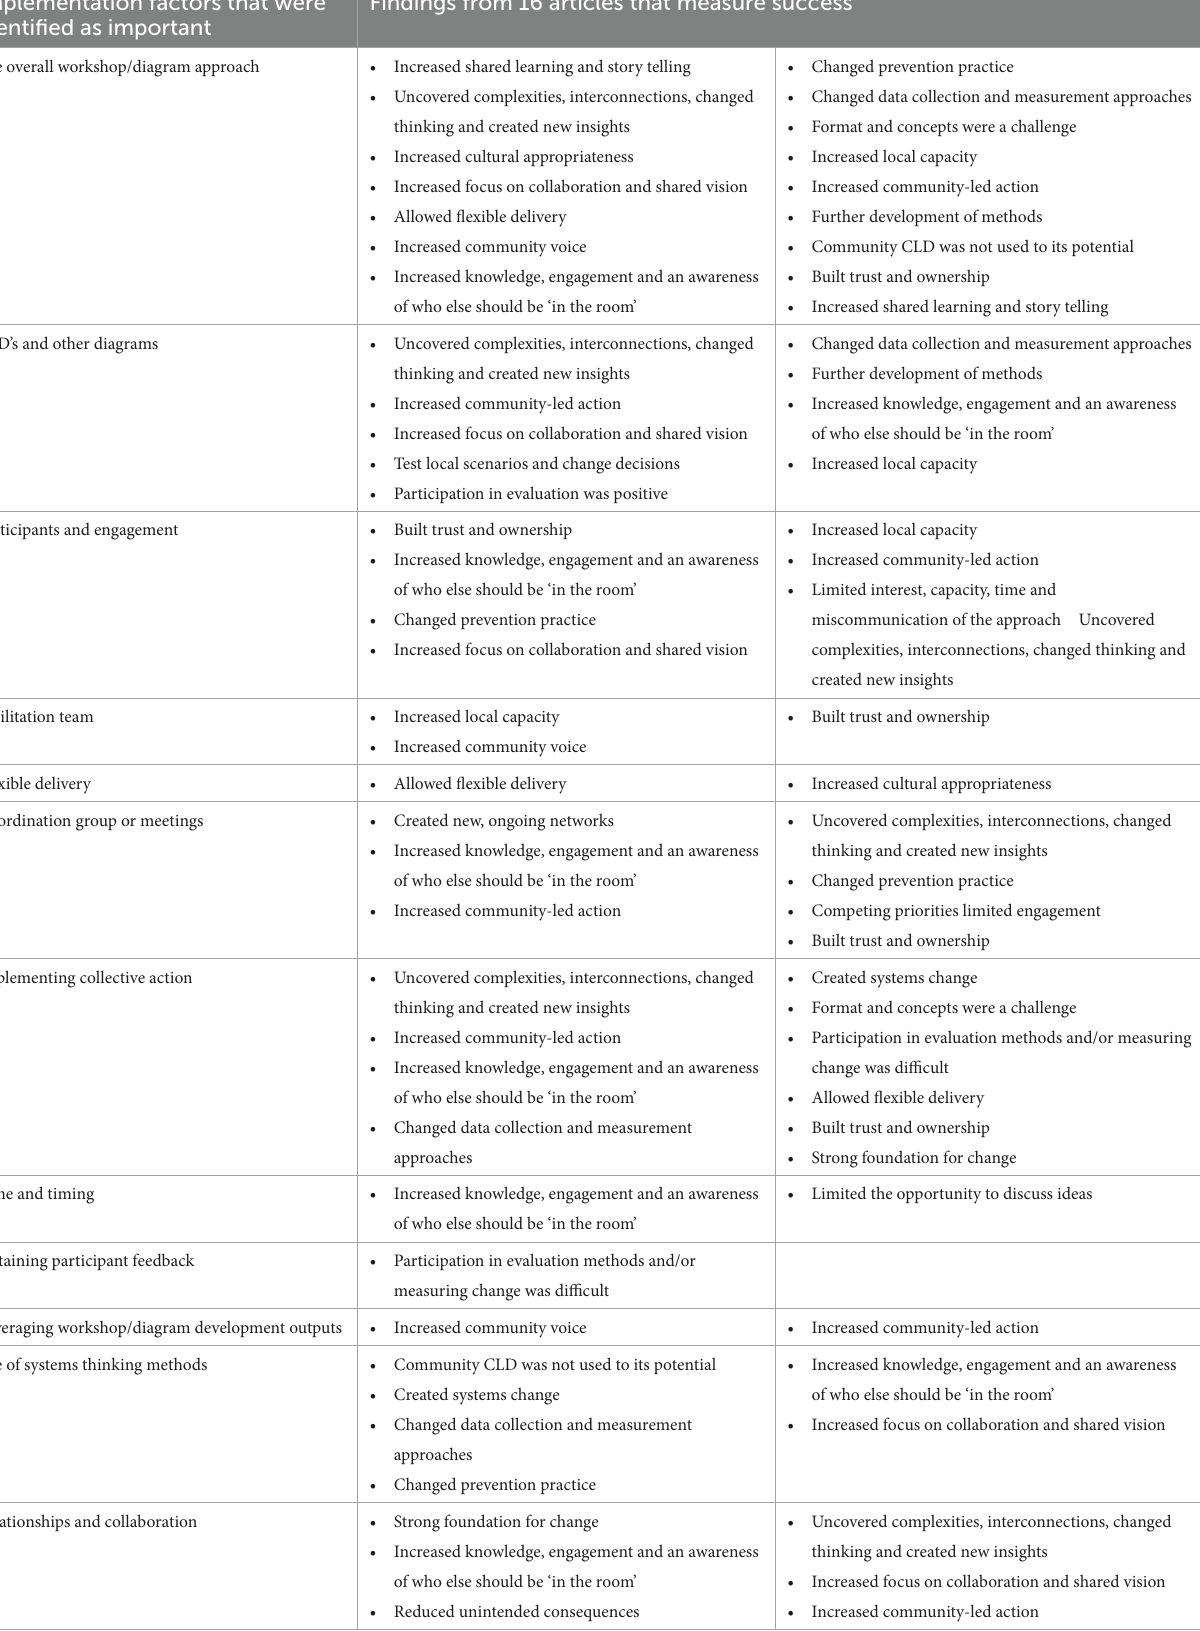
TABLE 6 Key implementation factors and how they affected findings in 16 studies that measured success. Implementation factors that were identified as